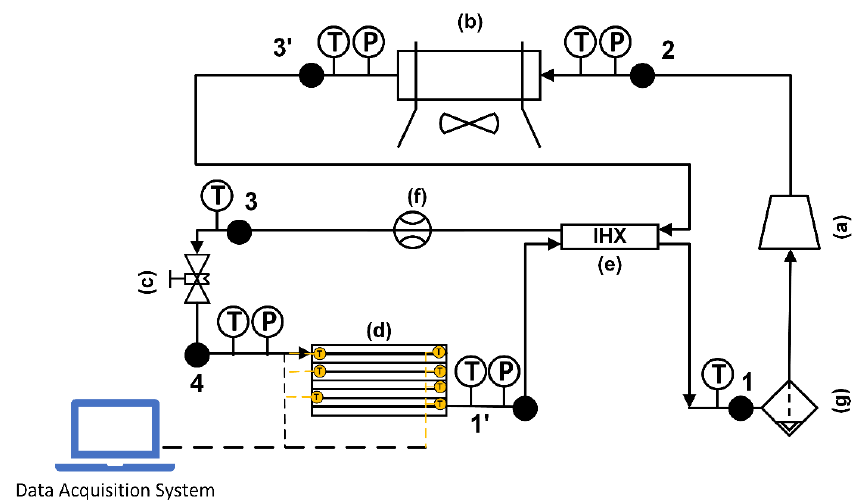
Figure 4. Schematic of the test loop for CO 2 air conditioning system: (a) a CO 2 compressor; (b) a gas cooler; (c) a throttle valve; (d) a microchannel evaporator; (e) an internal heat exchanger; (f) a flow meter; (g) a gas – liquid separator. Table 3. Accuracies and ranges of testing devices.